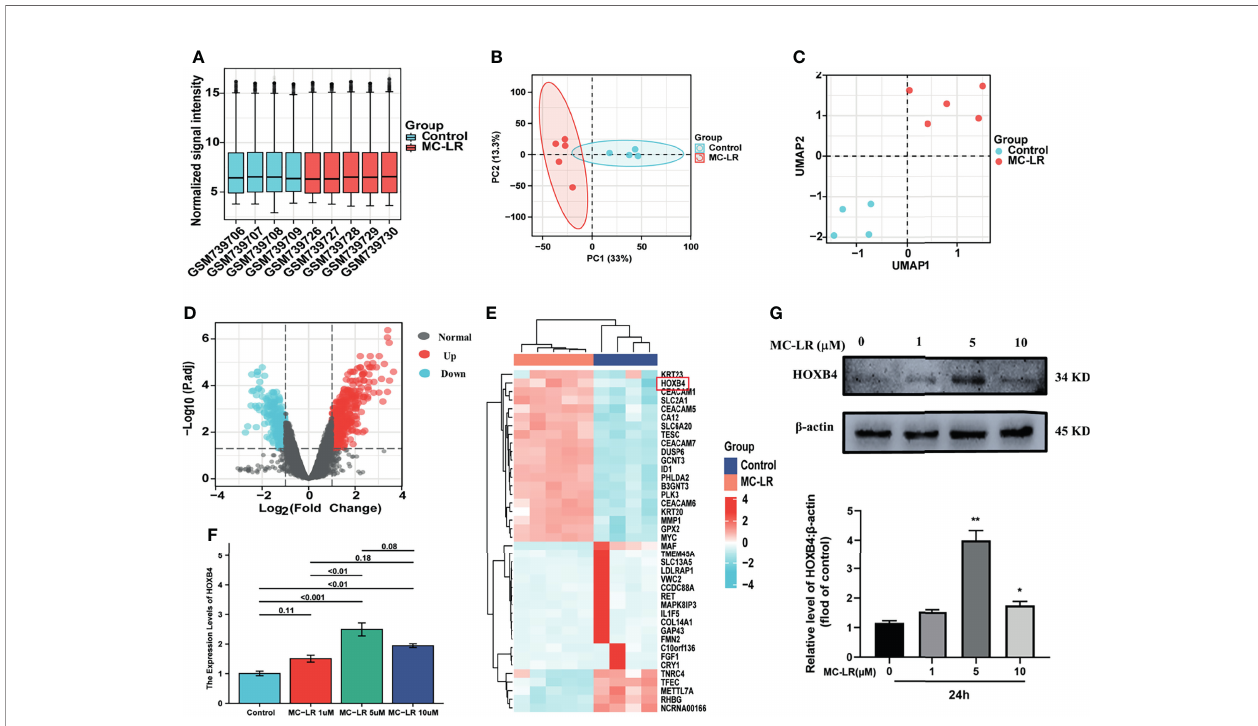
FIGURE 1 | Identifying the DEGs and picking HOXB4. (A) Degree of normalization between samples analysis on base of GSE29861. (B) Principal component analysis for GSE29861. (C) Dimension reduction analysis for GSE29861. (D) Volcano plot of the 741 MC-LR-related DEGs. The signi fi cant DEGs with P <0.05 and [logFC]>1.0 were considered as the cut-off criteria. The red dots represent the signi fi cantly up-regulated genes and the blue dots indicate the signi fi cantly down- regulated genes. (E) Heatmap of the top high or low expression of 20 DEGs in MC-LR-treated and control samples. (F) RNA expression of HOXB4 in Caco2 cells treated with MC-LR for 24h n=3. (G) Representative immunoblot images and quanti fi cation of HOXB4 in Caco2 cells treated with MC-LR for 24h n=3. * P <0.05 and ** P <0.01 vs. the untreated cells. DEGs, differentially expressed